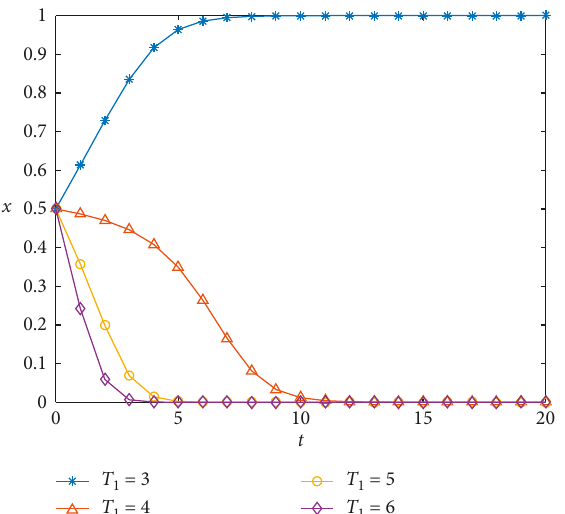
Figure 6: Influences of the free-riding benefit T